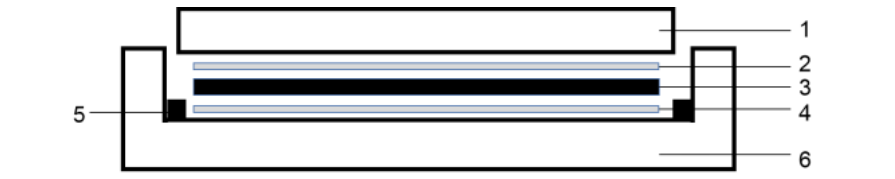
Figure 4. Schematic diagram for the arrangement of the hot pressing.